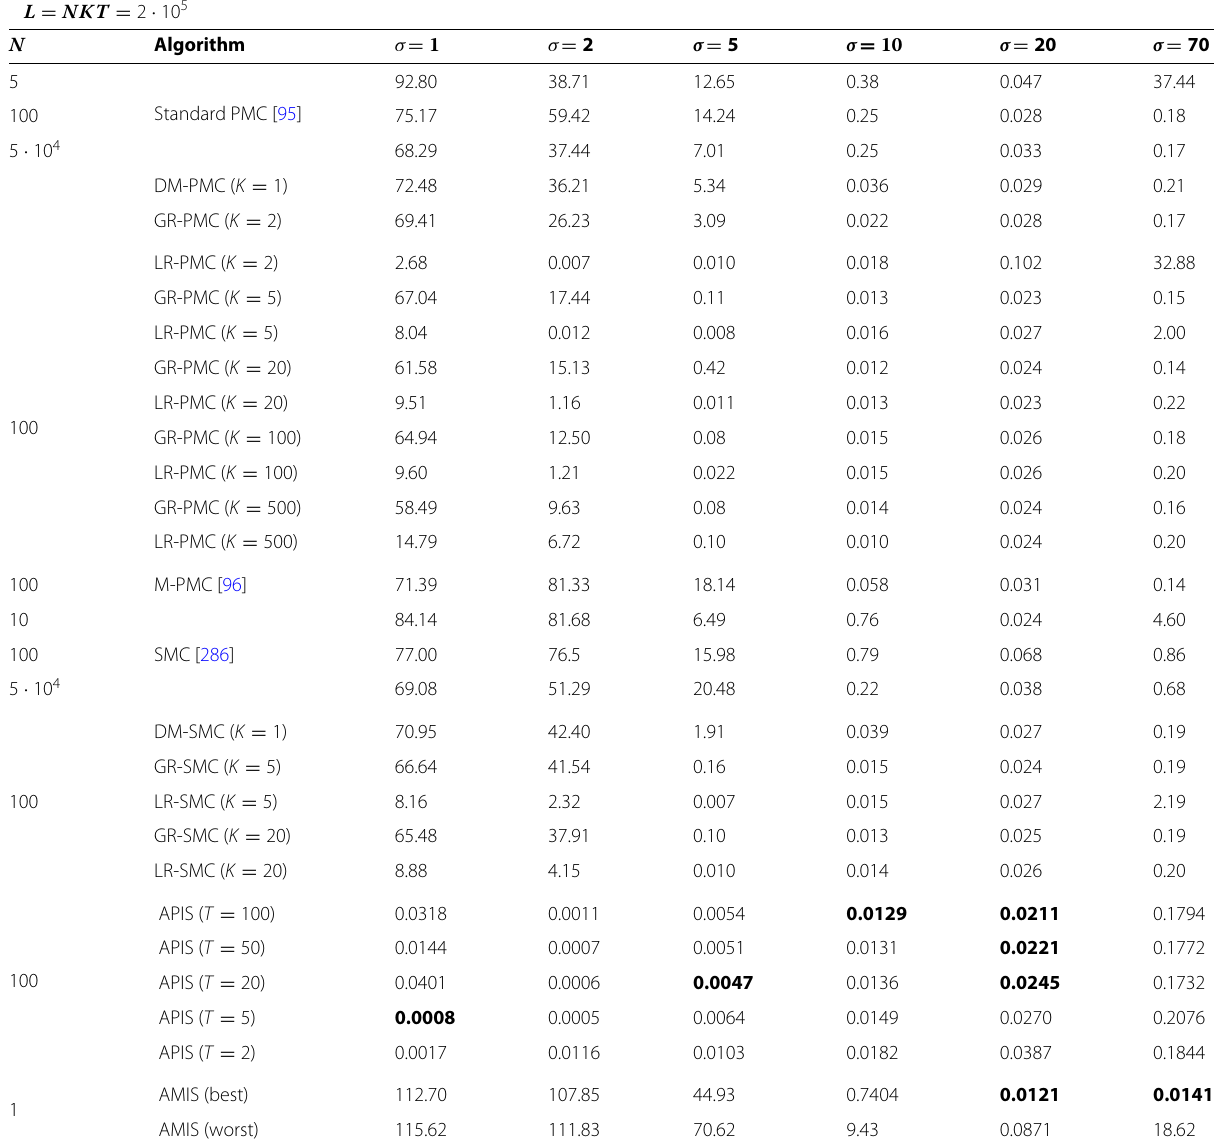
Table 8 MSE in the estimation of E ( θ ) , keeping the total number of evaluations of the target fixed to L = KNT = 2 · 10 5 in all algorithms, for the bivariate target in Section